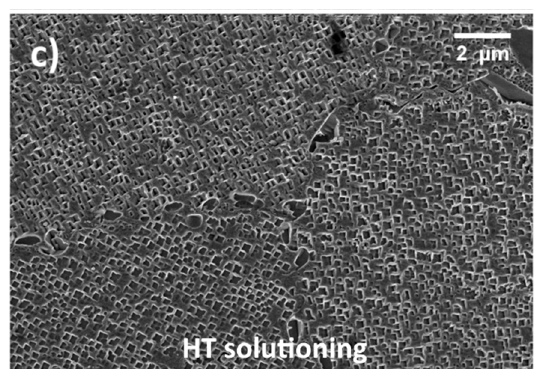
Figure 1. Astroloy in the as-HIPped (hot isostatic pressing) condition (adapted from [8]) ( a ); after sub-solvus solutioning ( b ); after super-solvus solutioning ( c ).